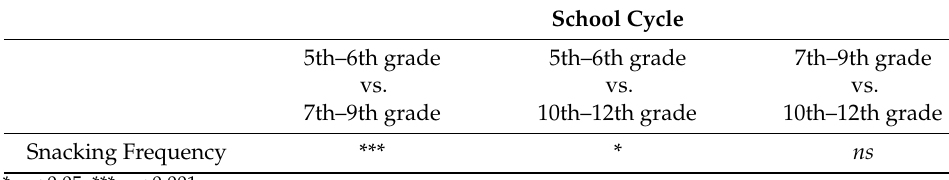
Table 4. Post hoc comparisons of snacking frequency according to the school